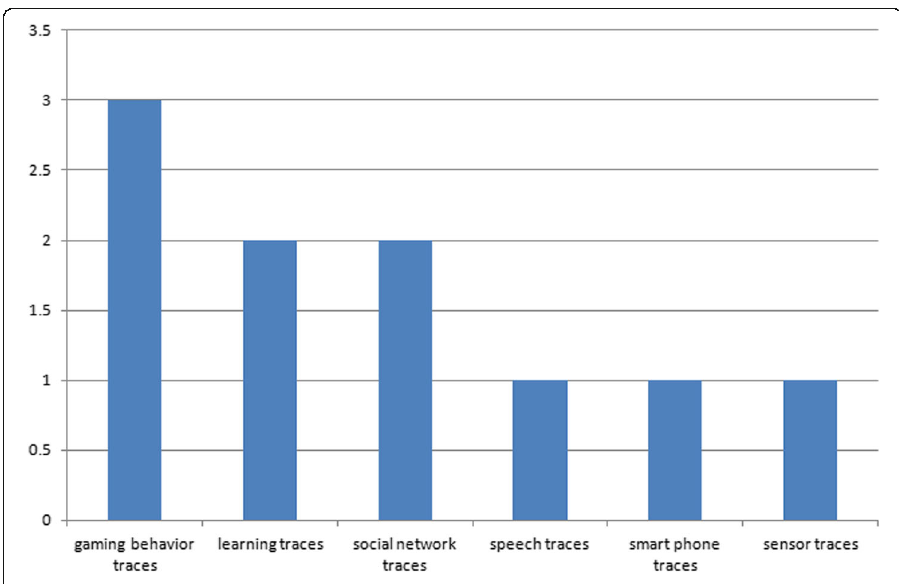
Fig. 4 Distribution of the used traces to implicitly model